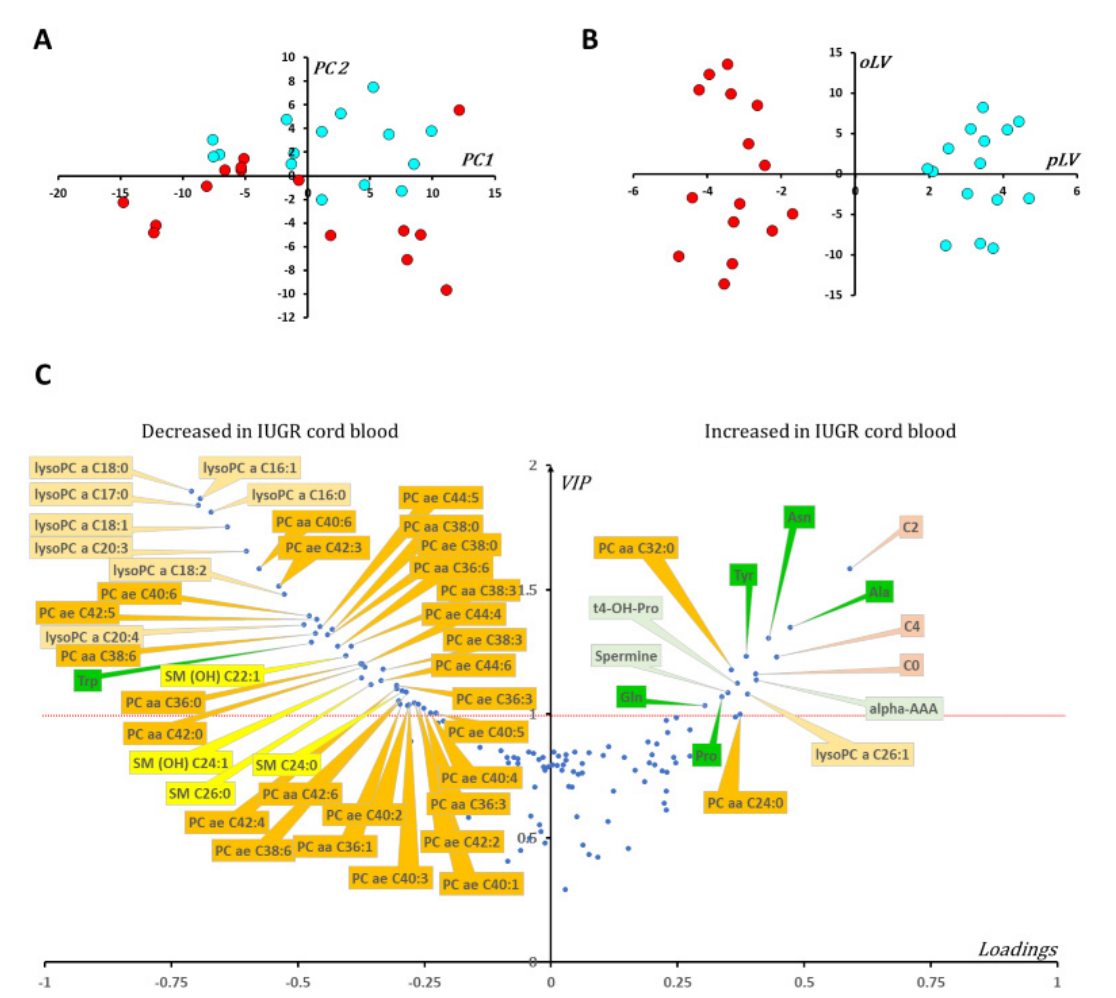
Figure 4. Multivariate statistical analysis of the metabolomic data from cord blood samples. ( A ) IUGR newborns (red dots) tend to have negative values in the second principal component (PC2) whilst control newborns (blue dots) have positive values in this component. There was no outlier according to Hotelling’s T2 distance. ( B ) The predictive latent variable (pLV) correctly predicts samples allocation according to IUGR status. Loadings vs. VIPs (volcano plot, C ) show increased concentrations of carnitine (C0) and two short chain acylcarnitine species (acetyl (C2) and butyryl (C4) carnitine, respectively) along with five amino acids (alanine (Ala), asparagine (Asn), tyrosine (Tyr), glutamine (Gln) and proline (Pro)), three biogenic amines (alpha-aminoadipic acid (alpha-AAA), trans-4-hydroxyproline (t4-OH-Pro) and spermine), one lysophosphatidylcholine (lysoPC) and two diacyl phosphatidylcholine (PC aa) species. On the other hand, many lipid species including diacyl- and alkyl-acyl-phosphatidylcholines, sphingomyelins and lysophosphatidylcholines of less than 22 carbons are found diminished in the cord blood plasma of newborns diagnosed IUGR compared to controls. The amino acid tryptophan is also relatively decreased in the IUGR cohort compared to controls. For phosphatidylcholines, the sum of the length of the two acyl or acyl-alkyl groups is noted after the C and is followed by the number of double bonds. The same notation was used to represent the length and the number of double bonds in the acyl chain of sphingomyelins and lysophosphatidylcholine species. Color code: amino acids: green; acylcarnitine species: brown; biogenic amines: light green; lysophosphatidylcholine species: light orange; phosphatidylcholine species: dark orange; sphingomyelins and hydroxy sphingomyelins: yellow. Figure 4C shows a deep lipid remodeling in the blood of IUGR newborns with de- creased levels of lysophosphatidylcholines with acyl chain of less than 22 carbon atoms, many phosphatidylcholine species, and some sphingomyelins. The ratio of